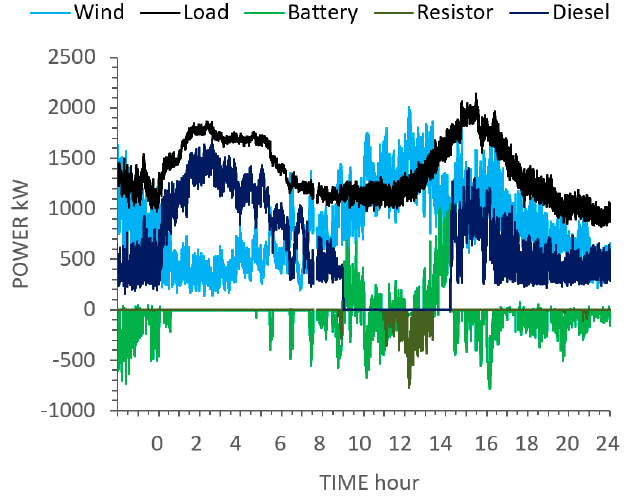
Figure 5. Twenty-four hours of King Island generation, showing diesel off operation as the afternoon sea breeze comes on.